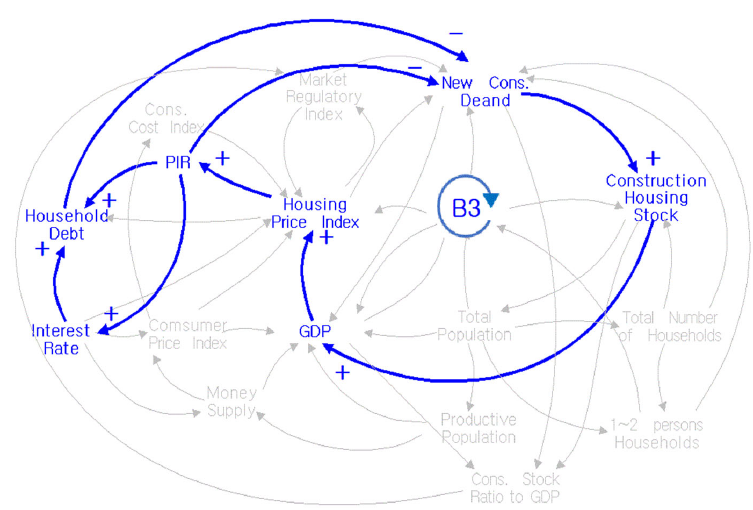
Figure 5. Loop in the influence of the residential construction market on interest rate increase and reduction.